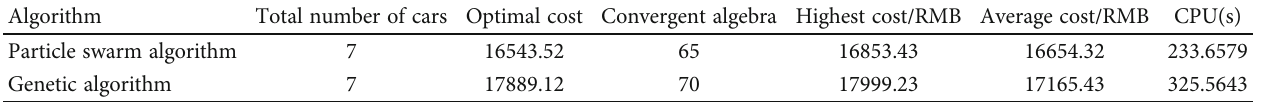
Table 3: Algorithm results comparison.